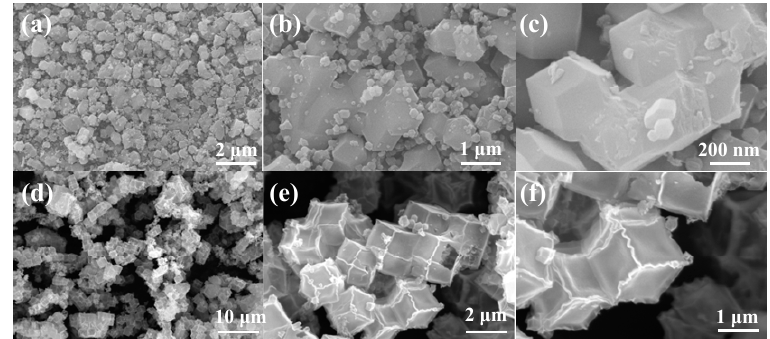
Figure 1. SEM images of ( a – c ) Zn-Co-MOF and ( d – f ) ZnO/Co 3 O 4 .